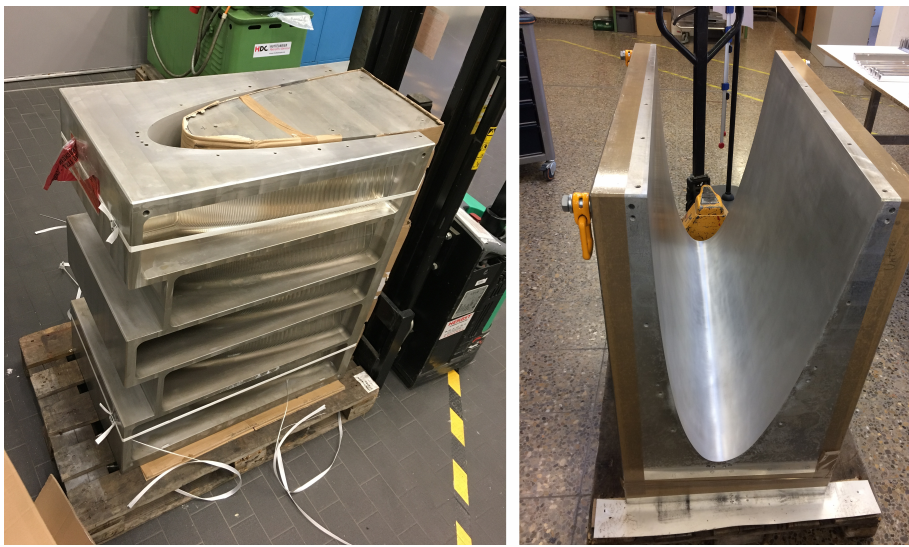
Figure 6. Photographs of the main aluminium negative mold after the wire electrical discharge machining (EDM) process and removal of the inner positive mold.